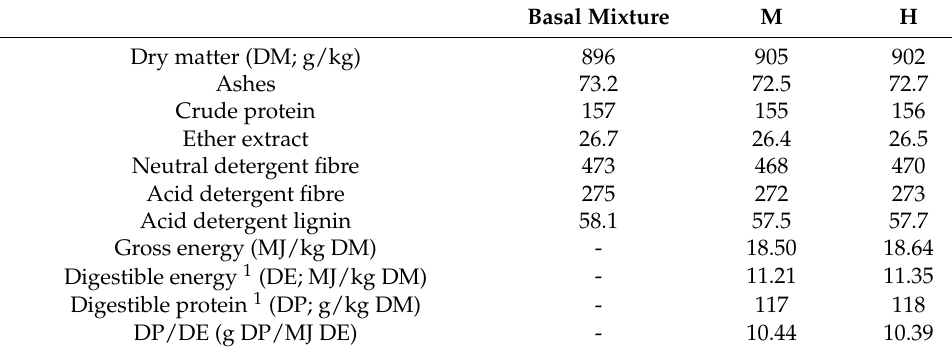
Table 2. Chemical composition (g/kg DM) of the basal mixture and experimental